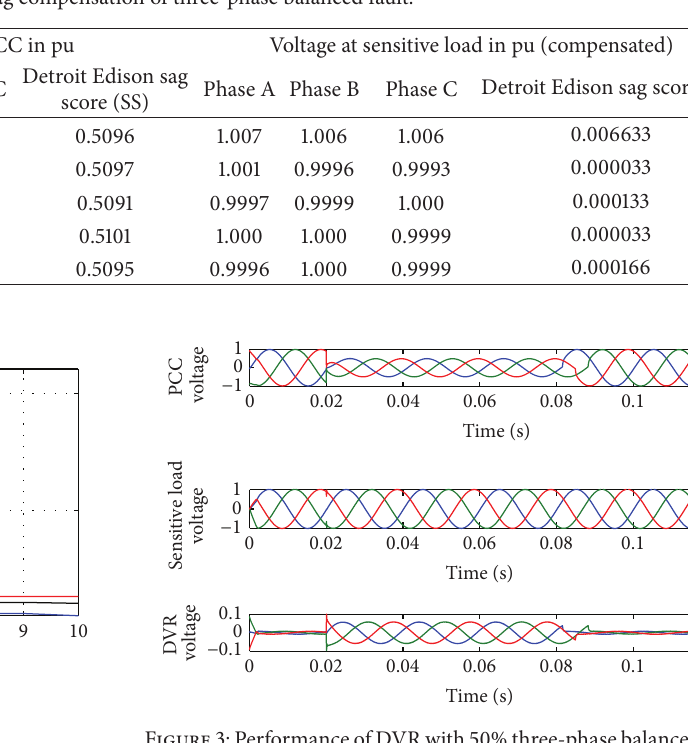
Figure 3: Performance of DVR with 50% three-phase balanced fault using AGPSO2 based PI